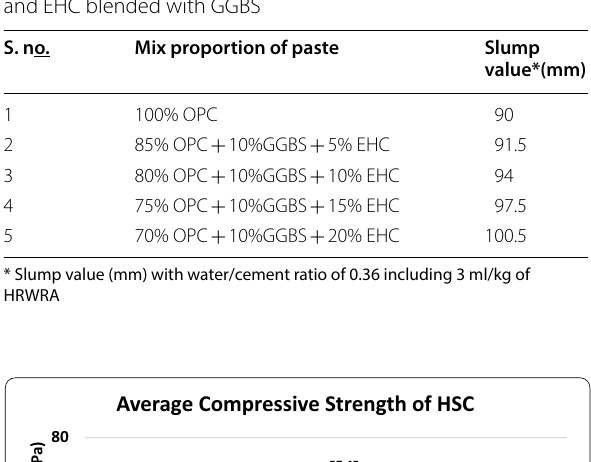
Table 5 Average slump test result of concrete with control mix and EHC blended with GGBS S. no.